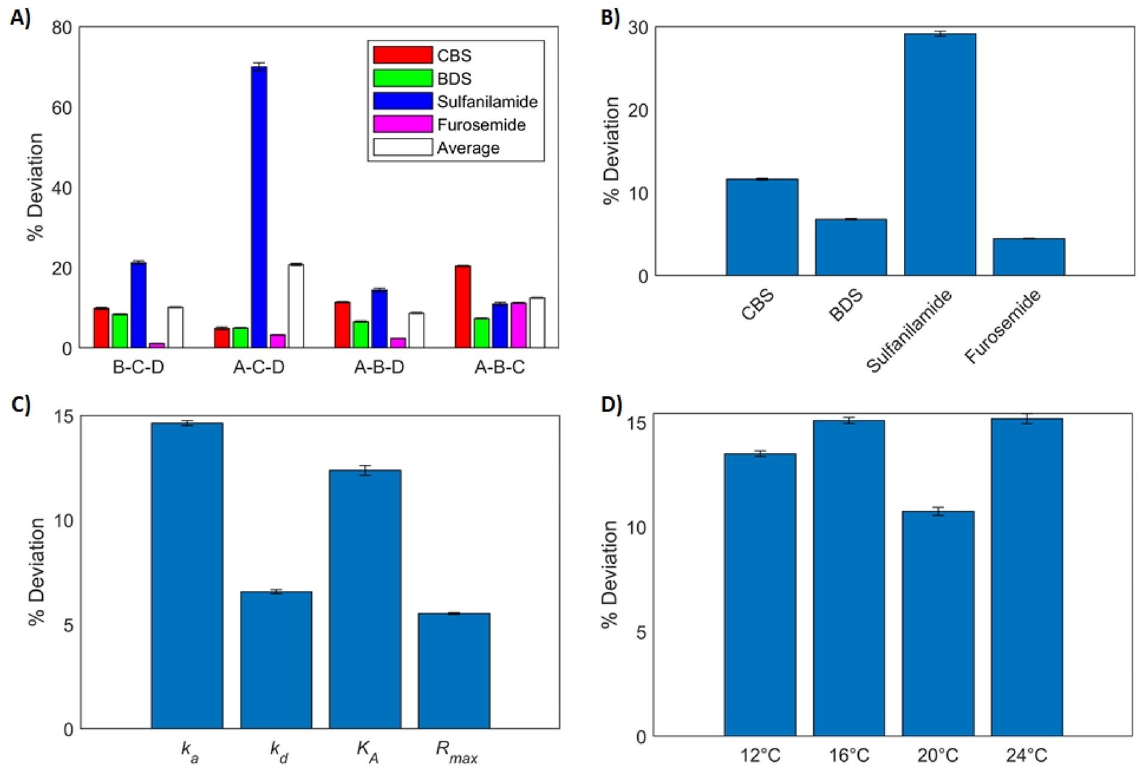
Figure 5. Average deviation between the parameters ( k a , k d , K A and R max ) identified from single-analyte experiments and parameters identified by our multi-analyte model with any combination of three mixtures (out of the four mixtures described in Table 1). In all cases, data generated at four temperatures were taken into account. ( A ) Average deviation computed over all parameters and temperatures for all analytes in all fits. ( B ) Average deviation over all parameters, fits and temperatures for each analyte. ( C ) Average deviation for all parameters. ( D ) Average deviation for all temperatures. Error bars were computed by propagating the standard error of the parameters identified from single-analyte and multi-analyte